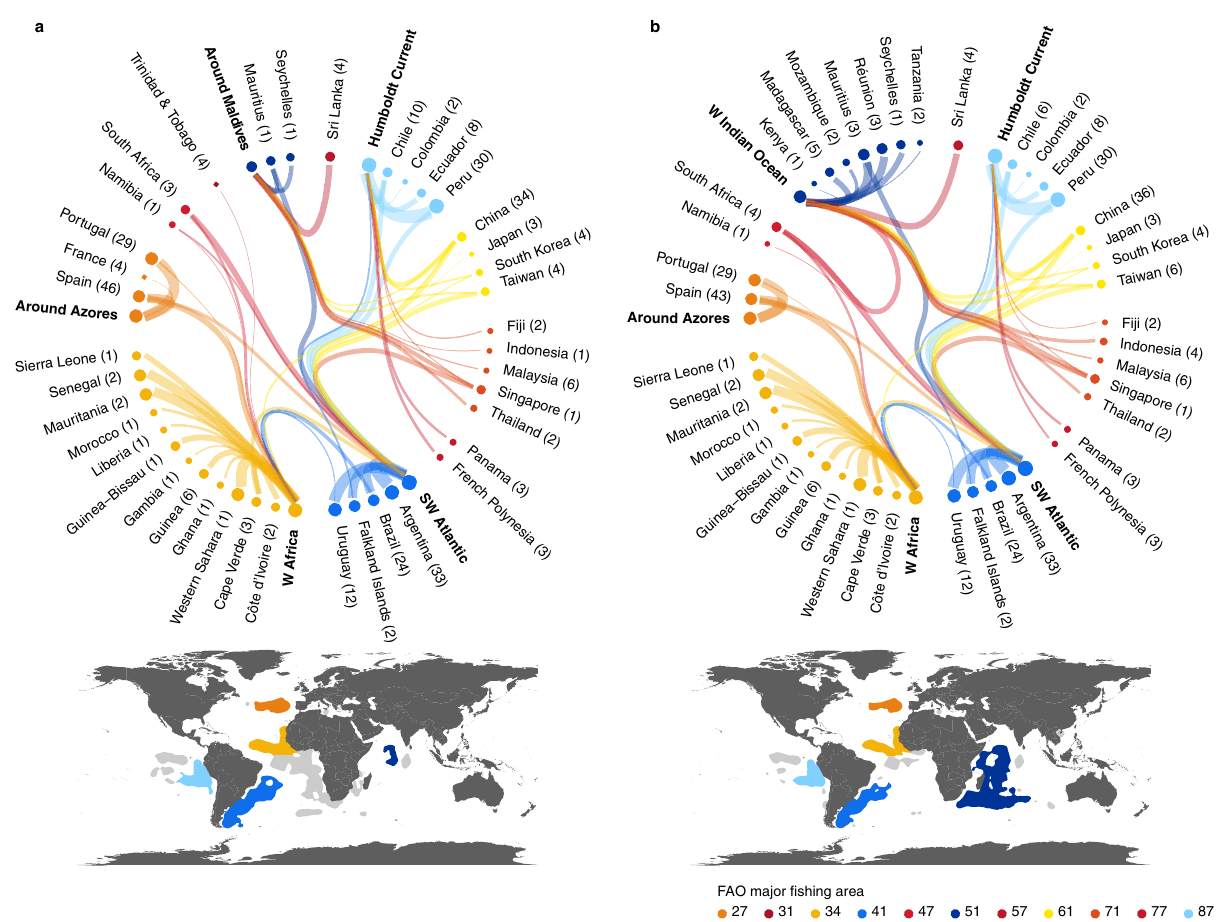
Fig. 4 Spatial linkages between at-sea risk regions and ports. Interconnections between selected high at-sea risk regions and arrival port countries for ( a ) labor abuse and ( b ) IUU fi shing. Node size and edge width are proportional to the number of trips from at-sea high-risk regions to destination countries (logarithmic scale). Countries within or bordering the same Food and Agriculture Organization (FAO) Major Fishing Area are grouped by color, and correspond to the geographic extent of the at-risk regions in the associated maps. The full extent of the at-risk regions from Fig. 2 are in gray. Text in bold re fl ect at-sea risk regions displayed in the maps, which were the focal areas evaluated. Values in parentheses are the number of unique destination ports within each country. For simplicity, each fi gure captures destination countries with more than 10 trips from each at-sea risk